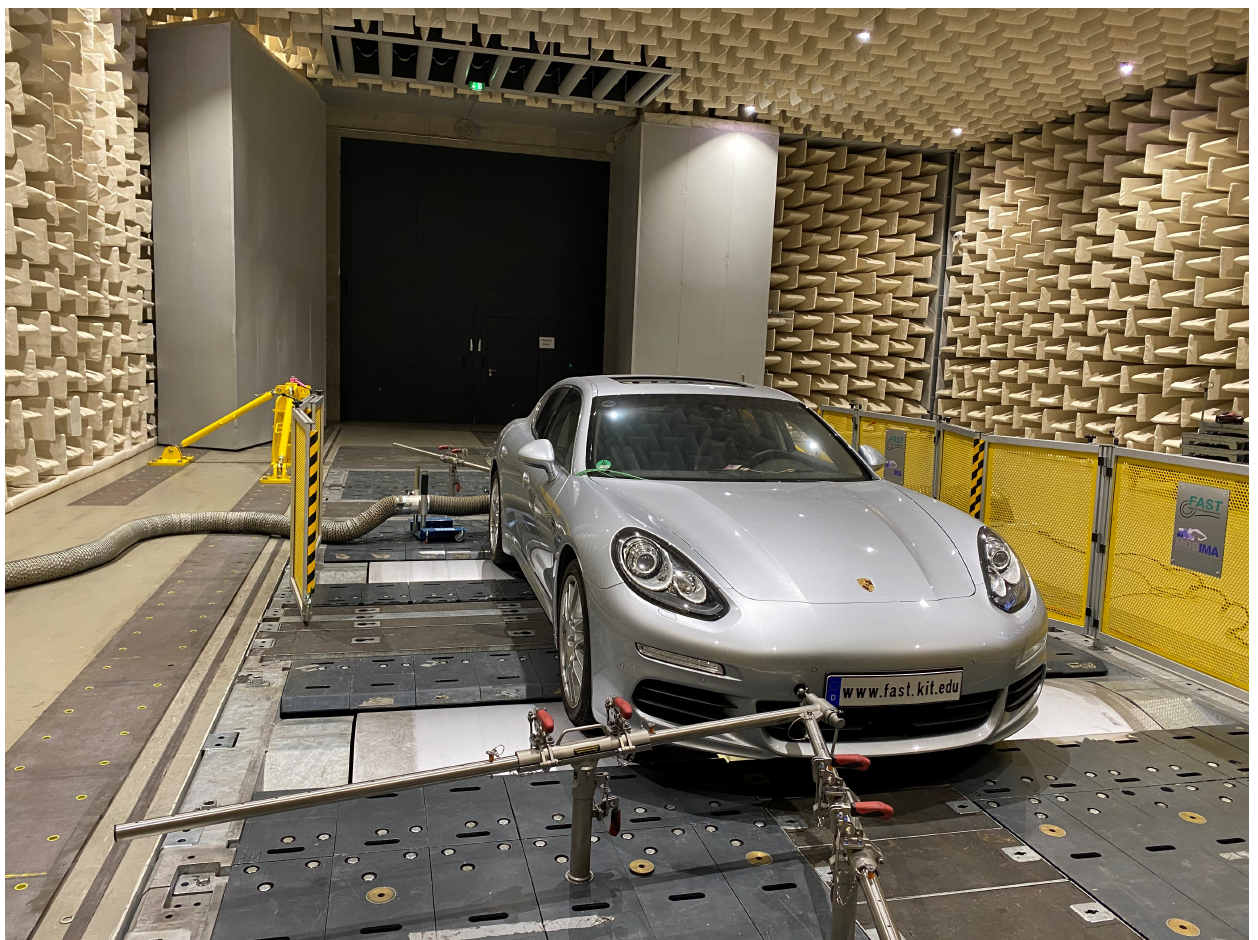
Figure 2. VuT mounted on a chassis